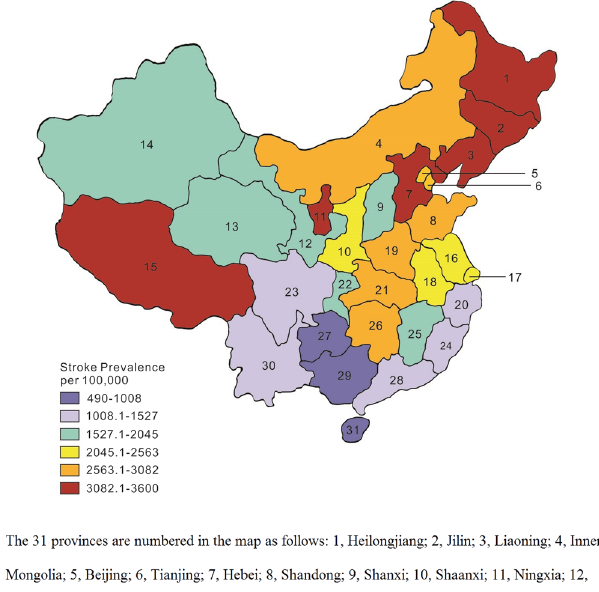
Figure 2. Map showing Age-standardized Prevalence of Stroke Across 31 Provinces in China. The colored map was drawn using Adobe Illustrator CS 6 (Adobe, California,